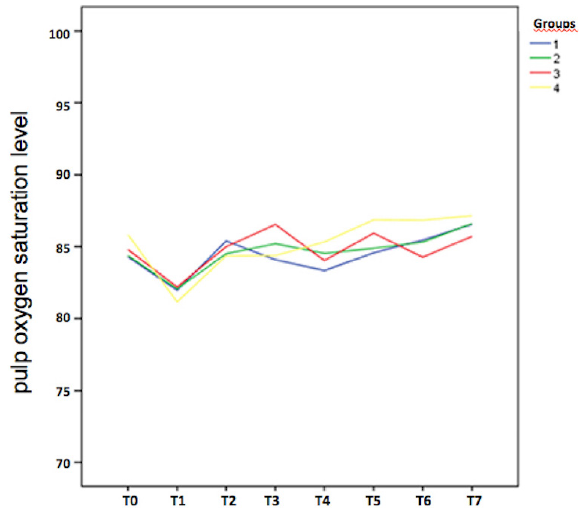
Figure 3- Graphical representation of pulp oxygen saturation level (%) at baseline, variations observed during whitening procedures, and levels at the end of the intervention in Group 1 (blue), Group 2 (green), Group 3 (red), and Group 4